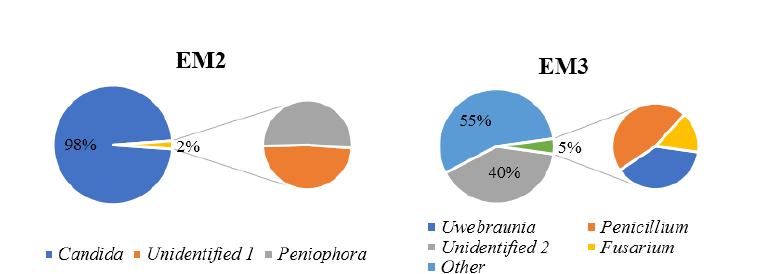
Figure 2. Distribution of OTUs of fungi genera in EM inoculants. EM2 = Produced in the region of Muriaé; EM3 = Produced in the region of Viçosa.